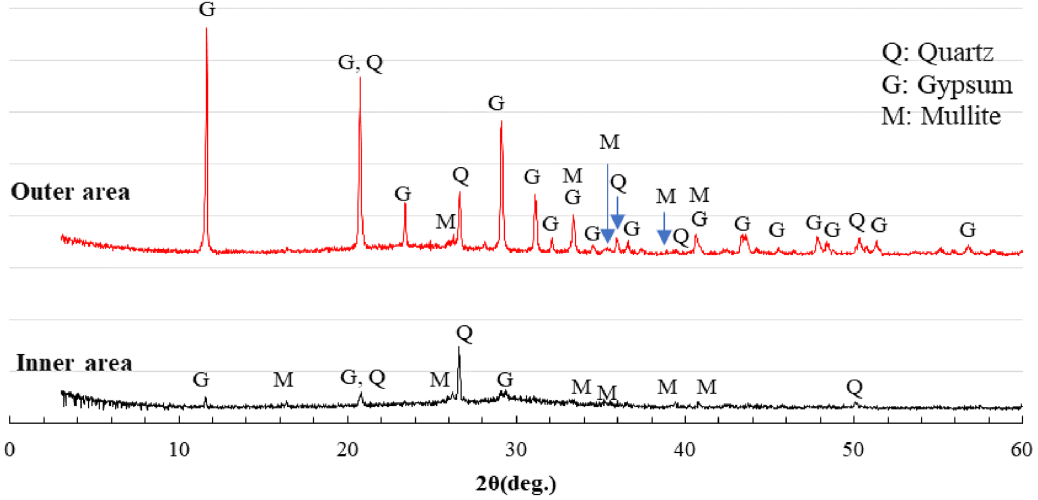
Figure 12. XRD patterns of series AS21 - 45 after sulfuric acid immersion.